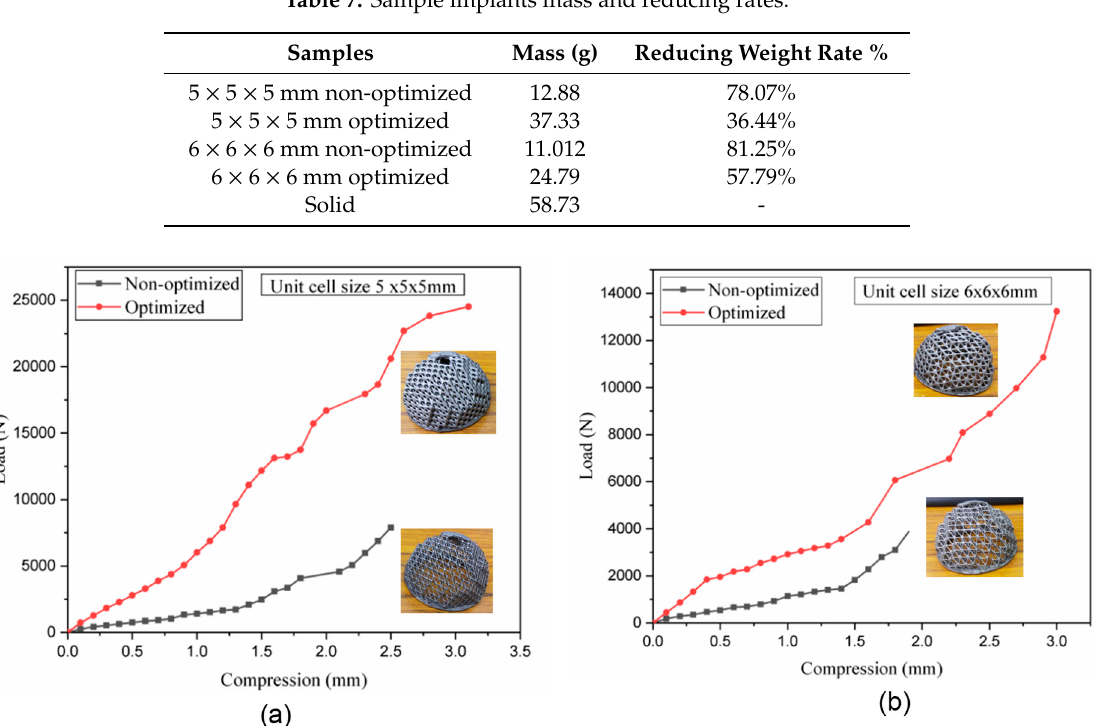
Figure 10. Compressive load-compression curves for optimized and non-optimized ( a ) unit cell size with 5 × 5 × 5 mm, ( b ) unit cell size with 6 × 6 × 6 mm.